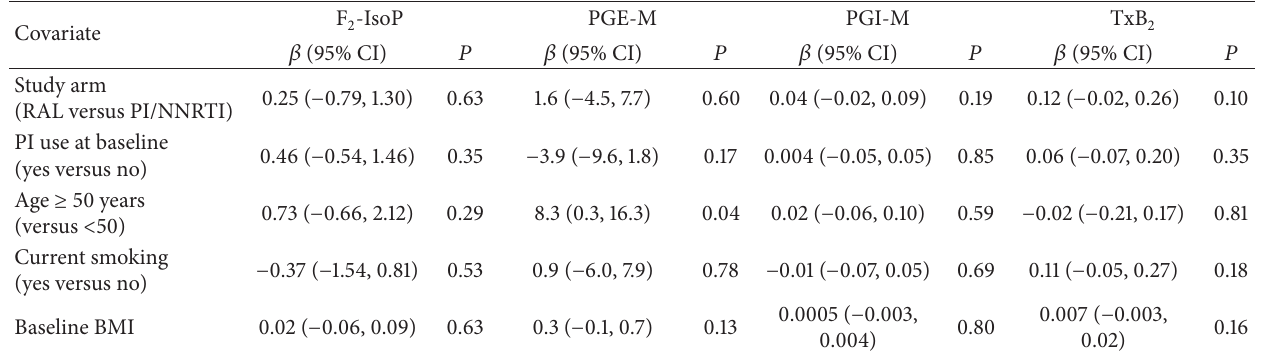
Table 3: Multivariate generalized linear models of predictors of 24-week eicosanoid